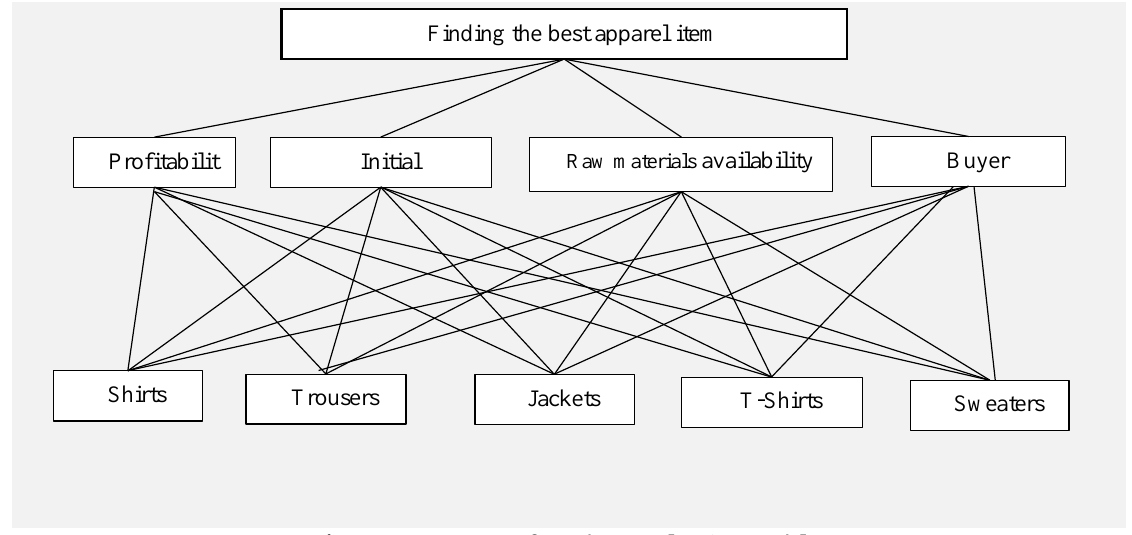
Figure 4. MCDM of products selection